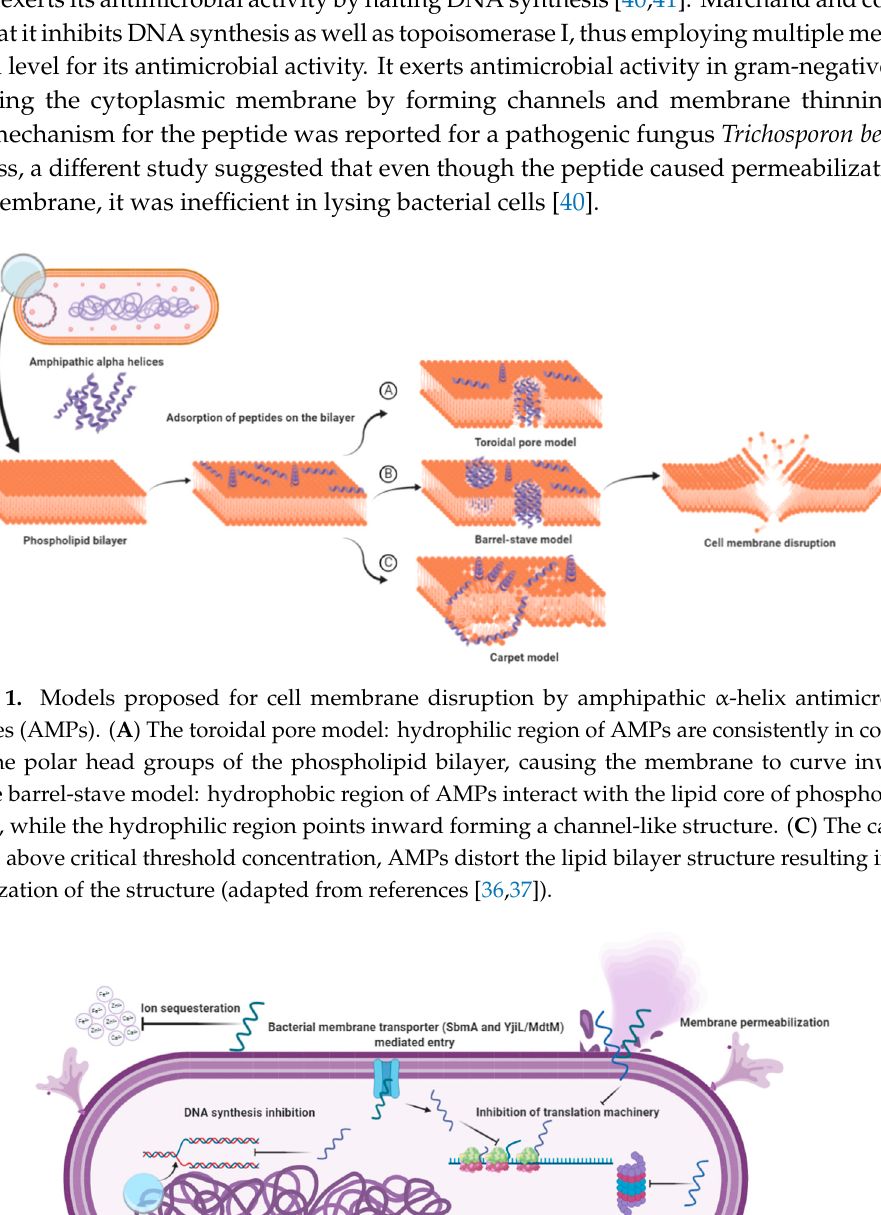
Figure 2. Different mechanisms are used by cathelicidins and β -defensins to eliminate the invading pathogens. After entry, the amphipathic peptides use secondary mechanisms such as inhibition of replication, translation, and sequestration of ions. In addition to membrane lytic action, an attack on these vital processes is life-threatening to bacterial cells and ultimately results in the demise of the cell.